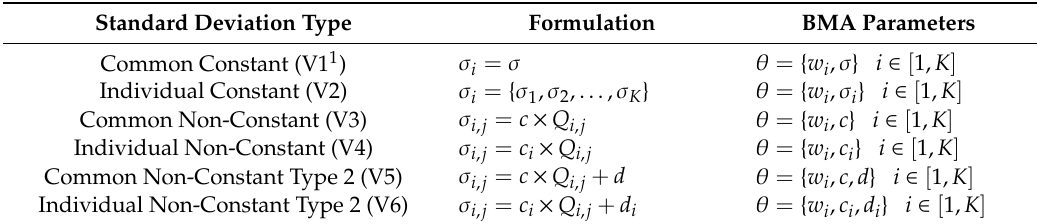
Table 2. The definitions and formulations of di ff erent standard deviation